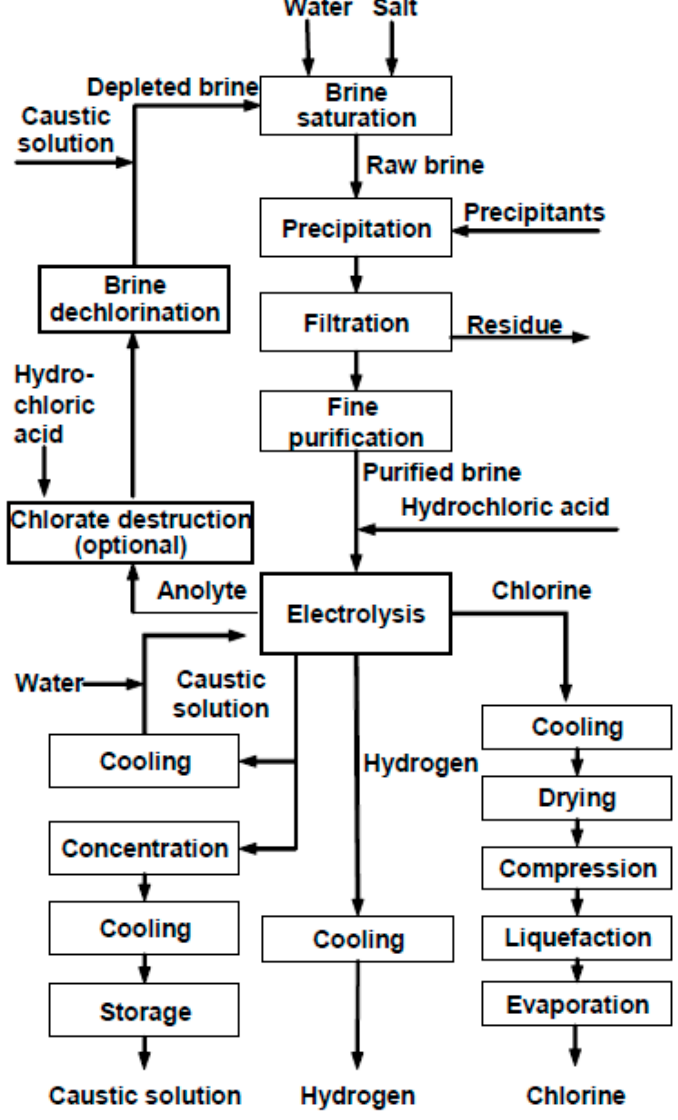
Figure 4. Process flow of simplified membrane cell process [26].